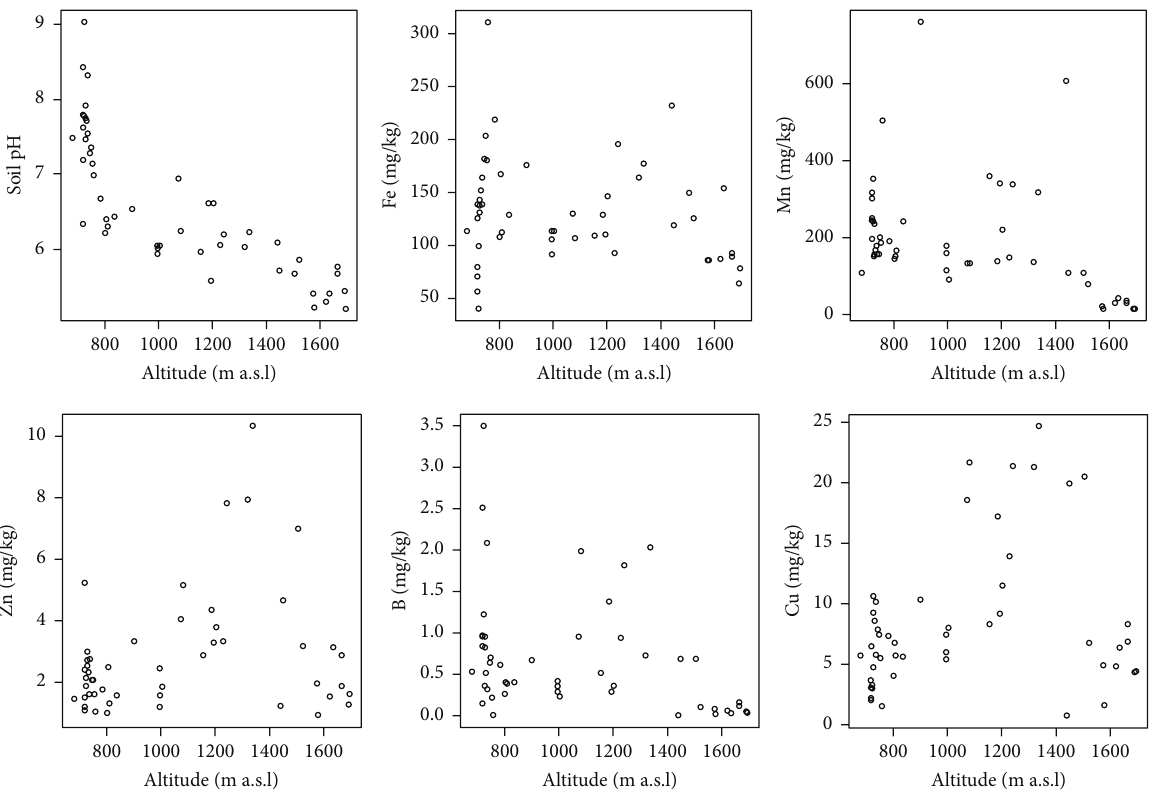
Figure 2: Patterns of soil properties along elevation gradient on Mount Kilimanjaro, Tanzania. Note . The upland (1438–1696 m a.s.l.); the midland (900–1438 m a.s.l); and the lowland (extending below 900 m